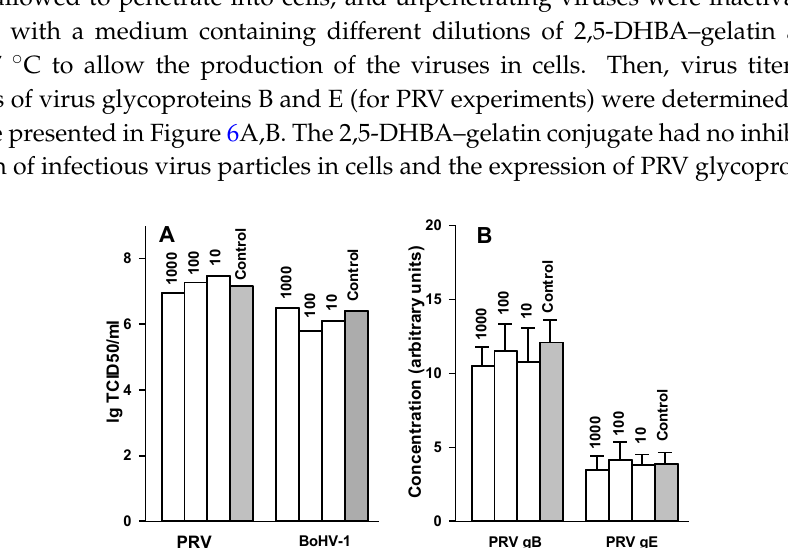
Figure 5. Effect of the 2,5-DHBA–gelatin conjugate on the penetration of viruses into cells ( A ) and the cell-to-cell spread of viruses ( B ). ( A ) The viruses were adsorbed to cells at 4 °C and washed following which 2,5-DHBA–gelatin was added to cells, and cells were incubated at 37 °C for 1 h to allow the viruses to penetrate into the cells. Unpenetrating viruses were inactivated, and viral plaques were detected after a 36–48-h incubation at 37 °C; ( B ) The viruses were adsorbed to cells, allowed to penetrate the cells, and unpenetrating viruses were inactivated as described in ( A ). Then, the cells were overlaid with DMEM-metylcellulose containing different concentrations of 2,5-DHBA–gelatin and incubated for 48–72 h at 37 °C, after which viral plaques were stained, and viral plaque sizes were determined. 2,5-DHBA–gelatin concentrations (µg/mL) are indicated above bars. Each value is the mean ± SD of three to five repetitions ( A ) or no less than 50 ( B ) repetitions. Asterisks indicate the statistical difference from the control: * p < 0.05. Finally, we tested whether 2,5-DHBA–gelatin inhibited the production of infectious virus particles and the expression of two PRV glycoproteins (gB and gE) after the penetration of the viruses into the cell. The viruses were adsorbed to cells at a multiplicity of 3–5 pfu per cell. The adsorbed viruses were allowed to penetrate into cells, and unpenetrating viruses were inactivated.